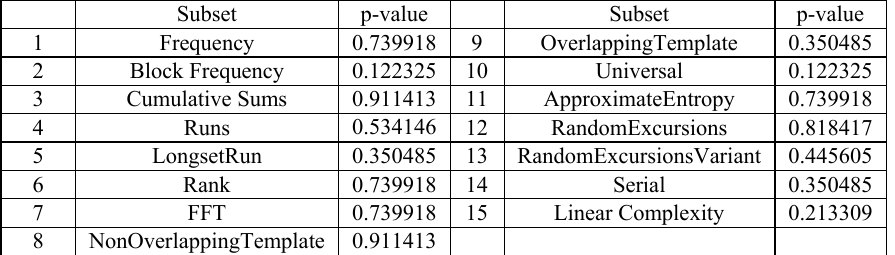
Table 1. Test result of random sequence.